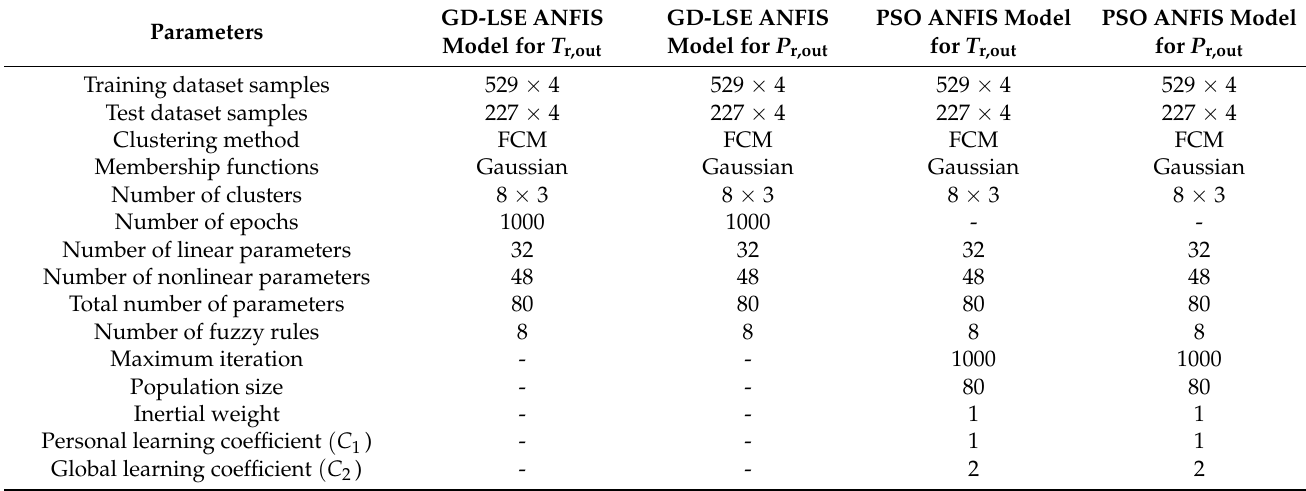
Table 4. Summary of R coefficients obtained for the evaporator outlet temperature